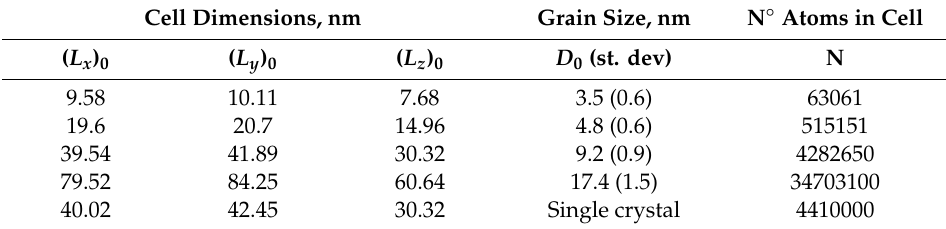
Table 1. Data of molecular dynamics (MD) calculation cells after 298 K